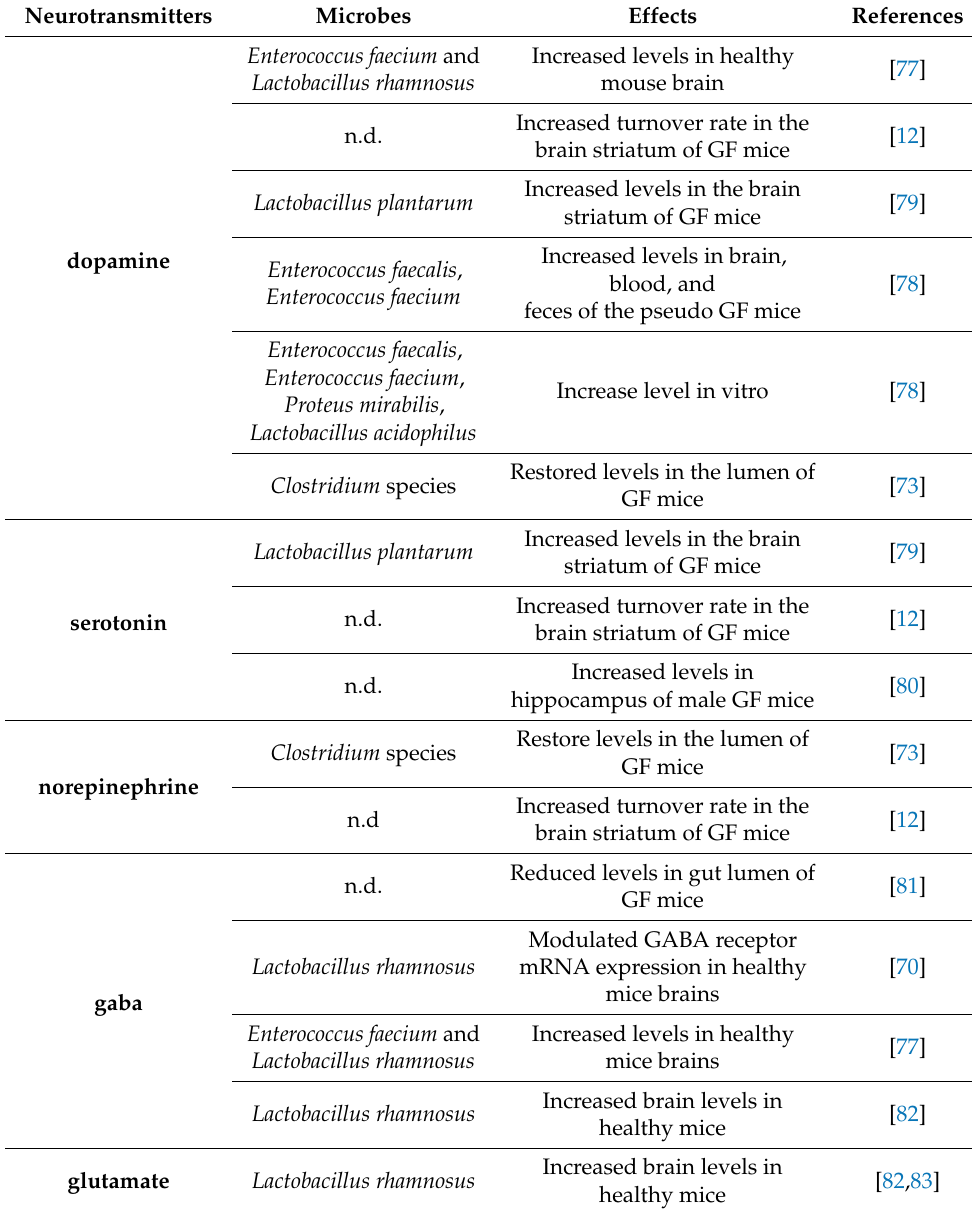
Table 1. Neurotransmitters levels modulated by gut